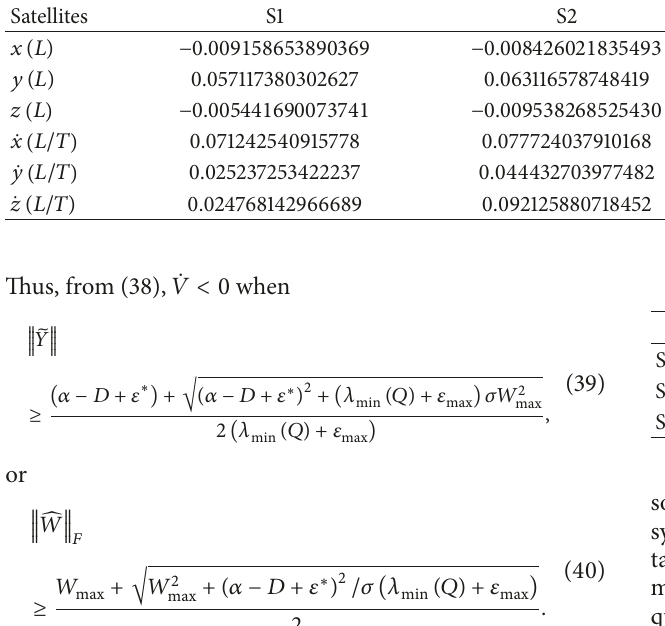
Table 1: Initial state of the Lagrangian satellites.